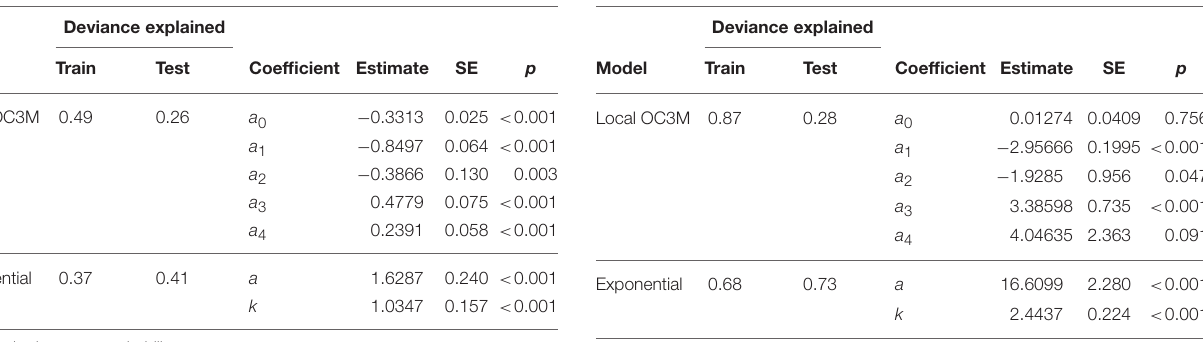
TABLE 8 | Summary of locally-tuned model output for the HAWQi monitoring buoy trained on closest-time